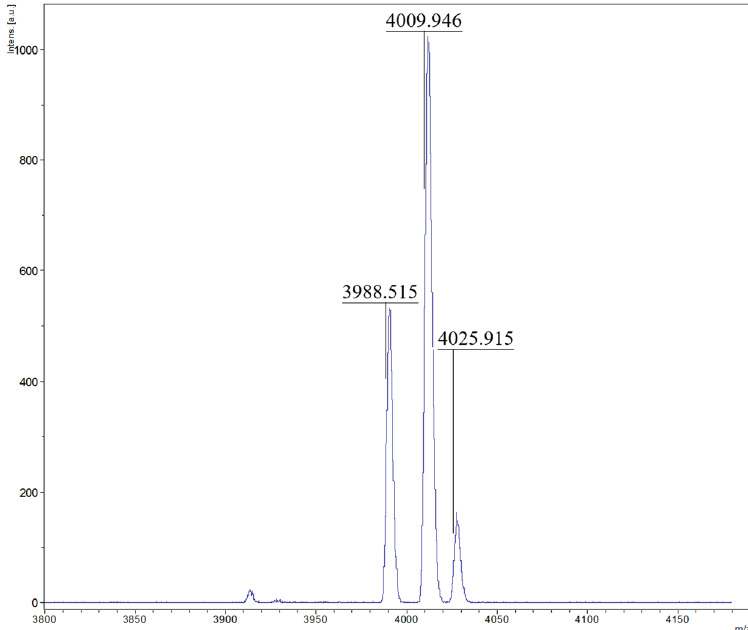
Figure 3. The mass spectrum of ( t - Bu - G 2 N ) 2 obtained by MALDI-TOF.